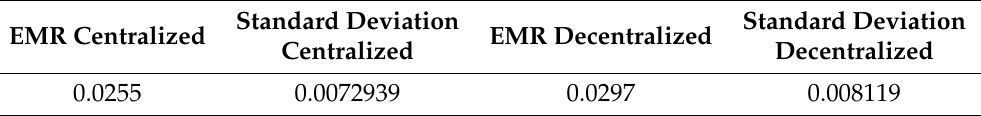
Table 1. Result of the state estimation process for the complete network.